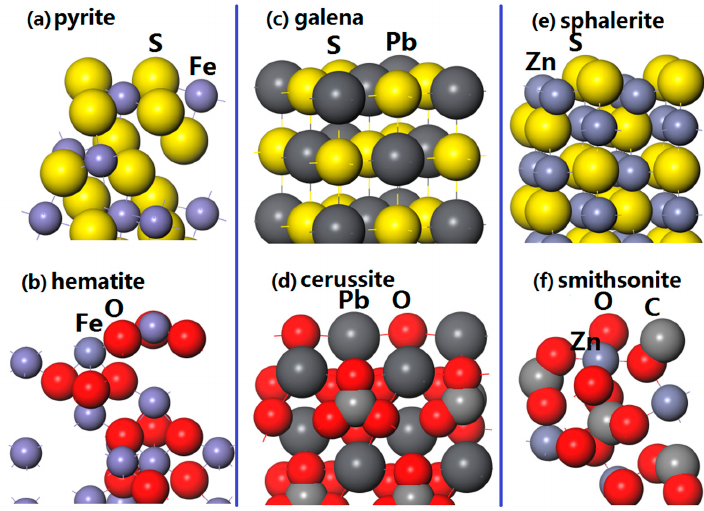
Figure 1. Slabs of represent minerals surfaces: ( a ) Pyrite (100) surface; ( b ) hematite (001) surface; ( c ) galena (100) surface; ( d ) cerussite (110) surface; ( e ) sphalerite (110) surface; ( f ) smithsonite (101) surface.